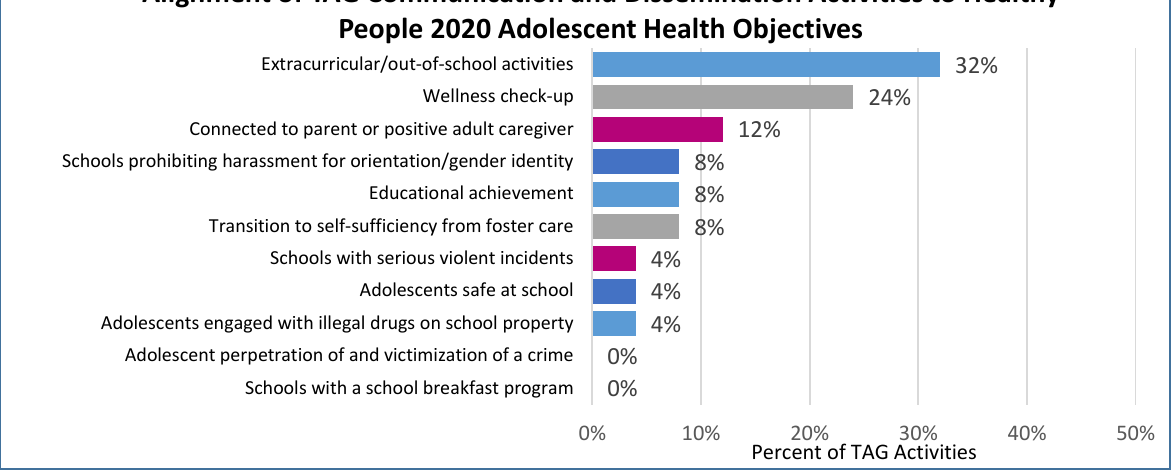
Figure 1. Alignment of TAG Communication and Dissemination Activities